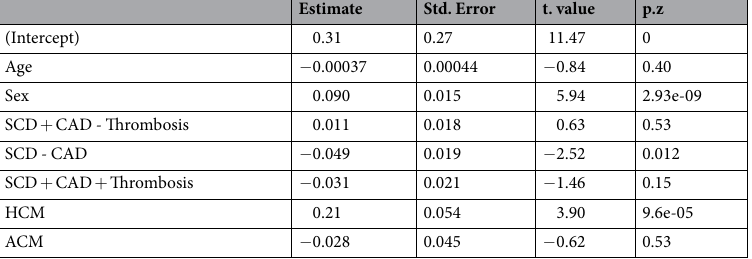
Table 3. Linear mixed model evaluating TMAs 1 & 2 for correlation with MYL4 positivity. Male sex and HCM were significantly associated with MYL4 positivity along with a weaker signal for SCD without